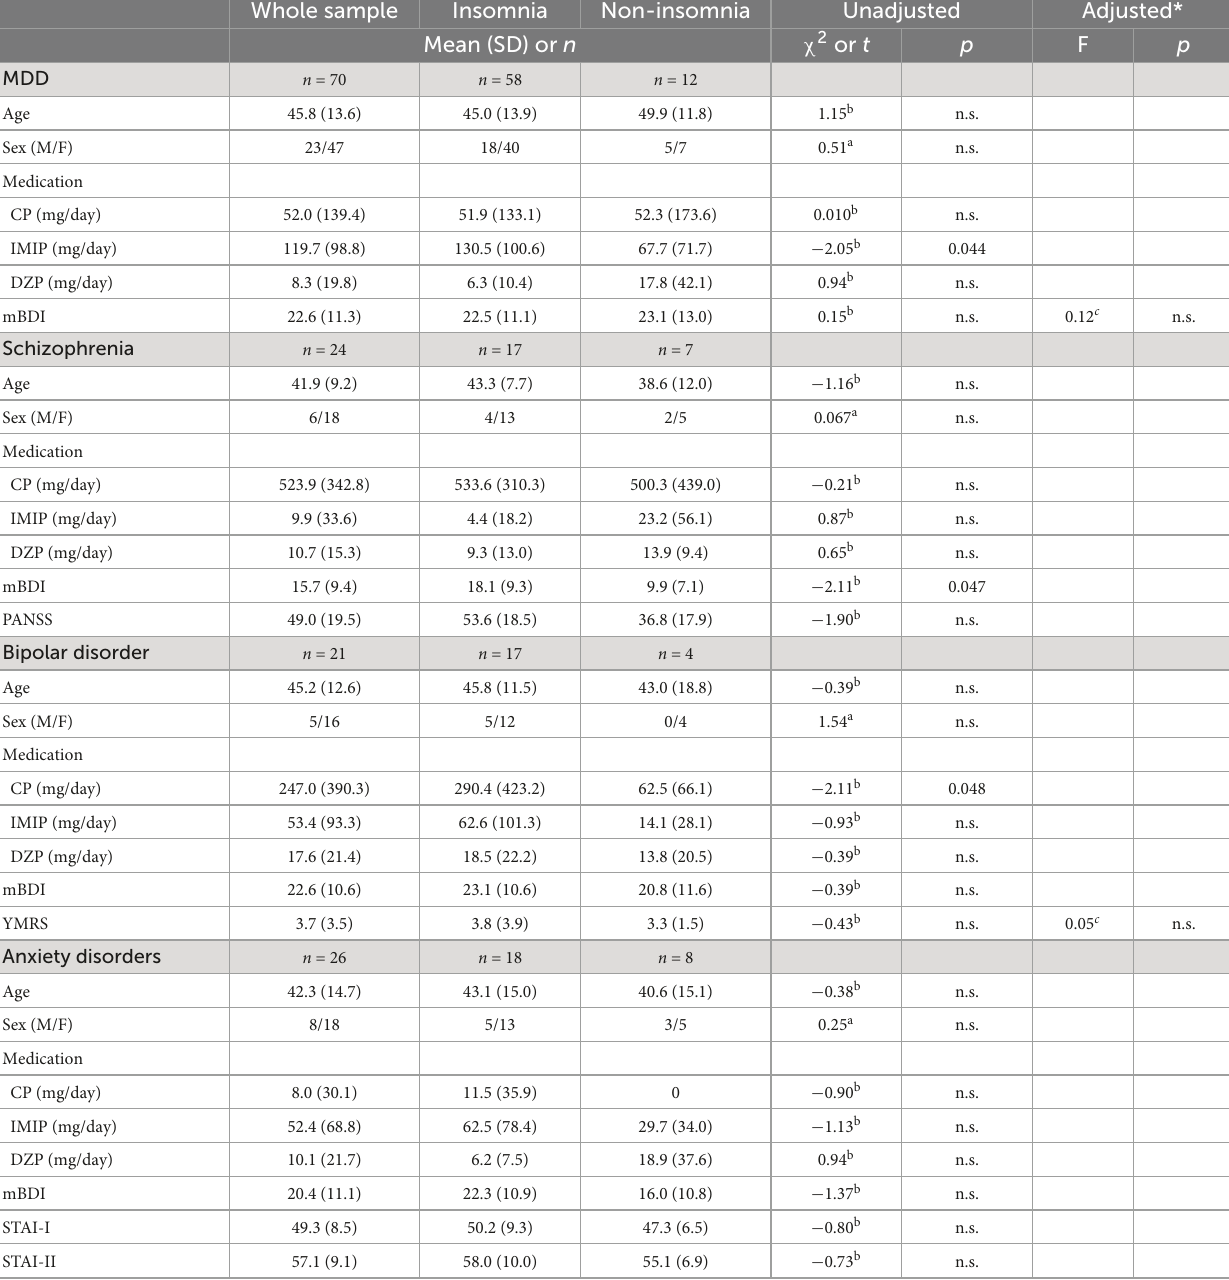
TABLE 2 Comparison of background information between the insomnia and non-insomnia groups as defined by sleep electroencephalography. Whole sample Insomnia Non-insomnia